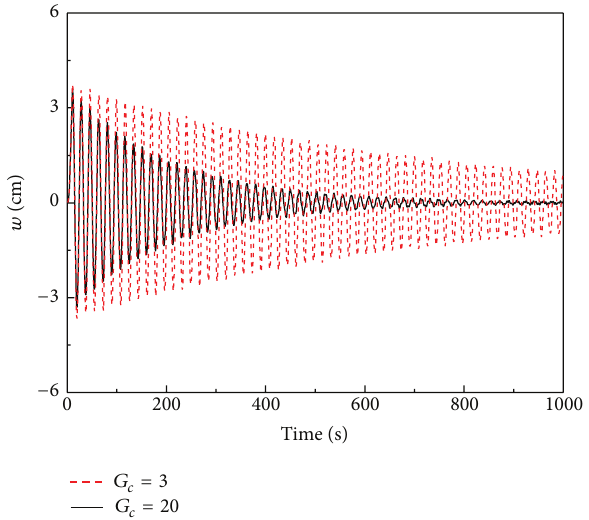
Figure 20: Vibration of the underwater structure with feedback control loop under active